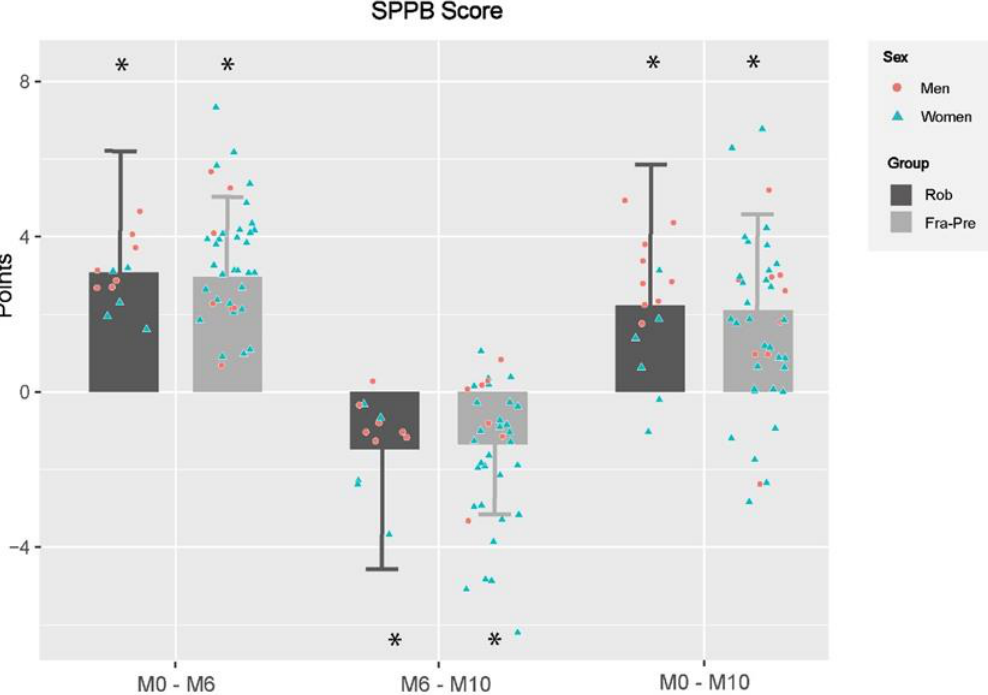
Figure 3. Changes in functional capacity between and within training subgroups in different evalu- ation periods. M0 – M6: changes between baseline and 6th month; M6 – M10: changes between 6th and 10th month; M0 – M10: changes between baseline and 10th month; SPPB: Short Physical Perfor- mance Battery; PRE-FRA: Prefrails and frails participants of training group; ROB: Robust partici- pants of training group; TRAIN: training group; *: significant differences within groups changes; Differences were obtained by linear mixed models adjusting by baseline values, gender and age; Statistical significance was set at p < 0.05.